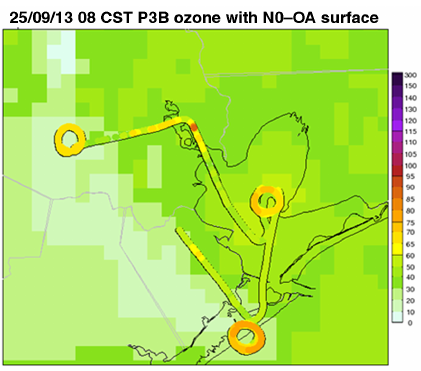
Figure 12. Ozone along aircraft tracks on 25 September at 13:00CST, overlaid upon model No-OA surface ozone. Plumes can be seen as dark purple circles in Galveston Bay. The numerical range of the right-side color scale is 0 to 300ppb. Higher values than 300ppb have the same color as